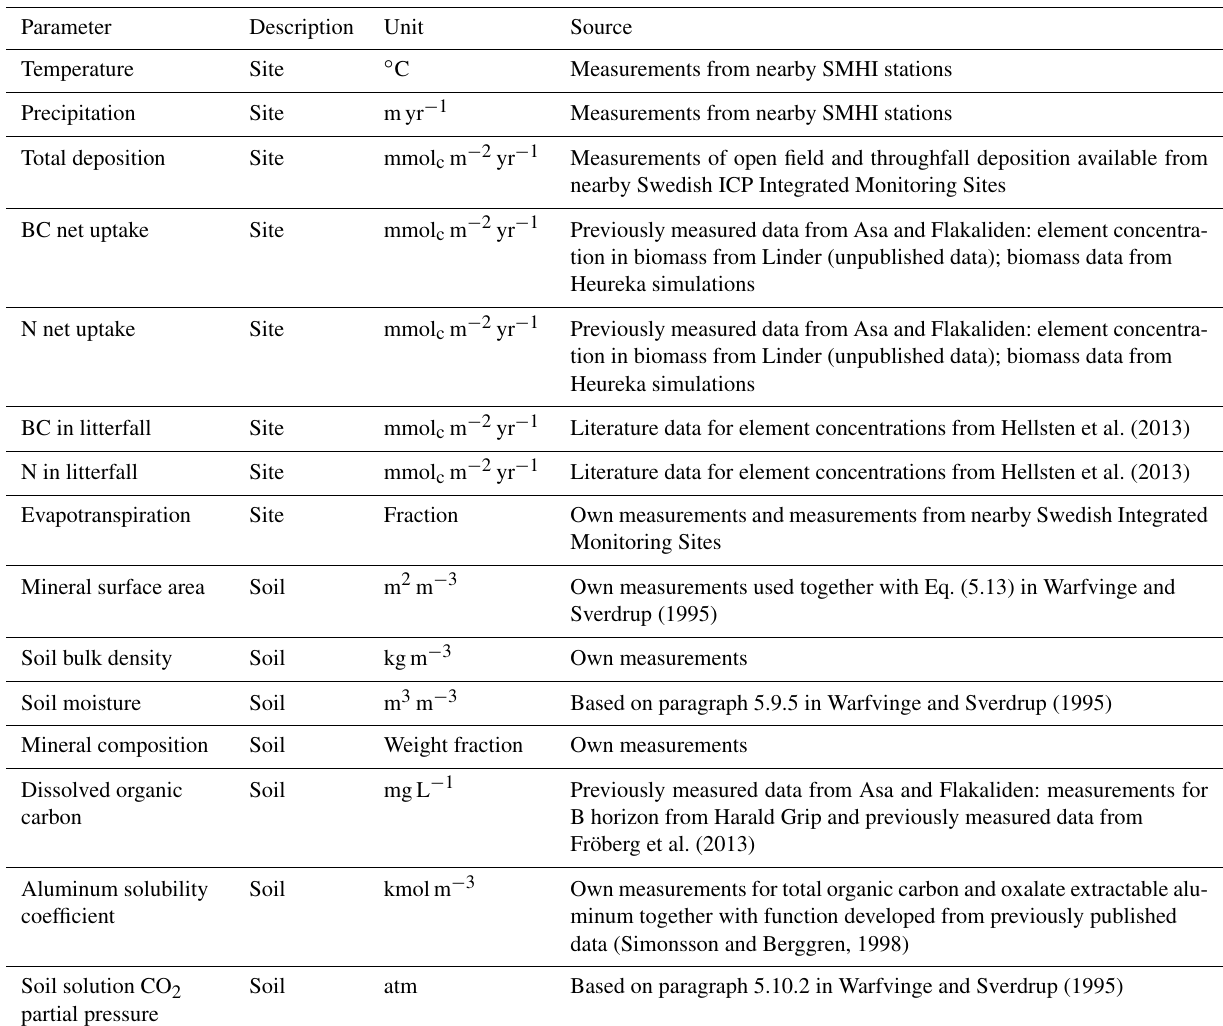
Table 2. PROFILE parameter description